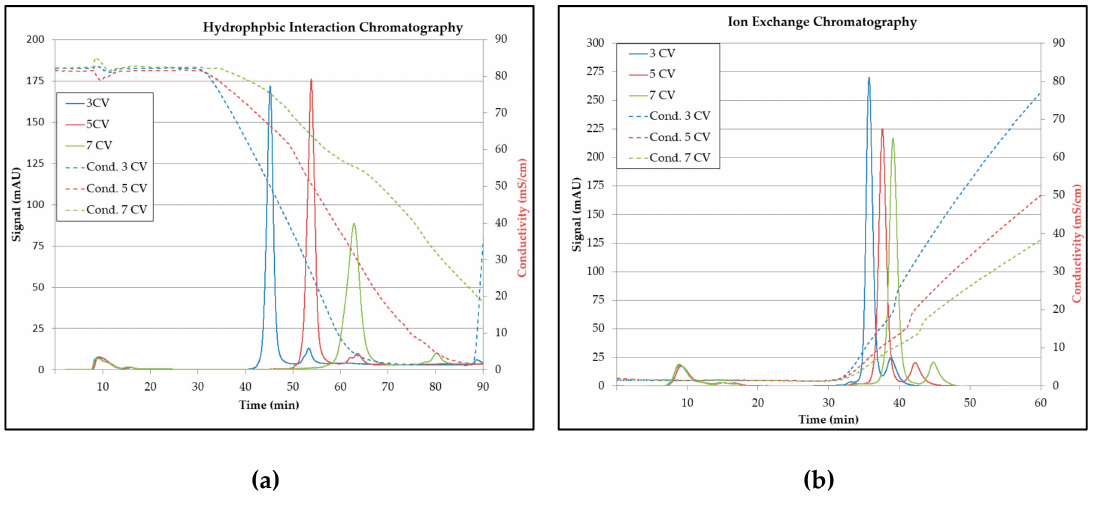
Figure 20. Influence of the gradient length for the separation: ( a ) For hydrophobic interaction and ( b ) for ion exchange. CV (column volume), Cond.